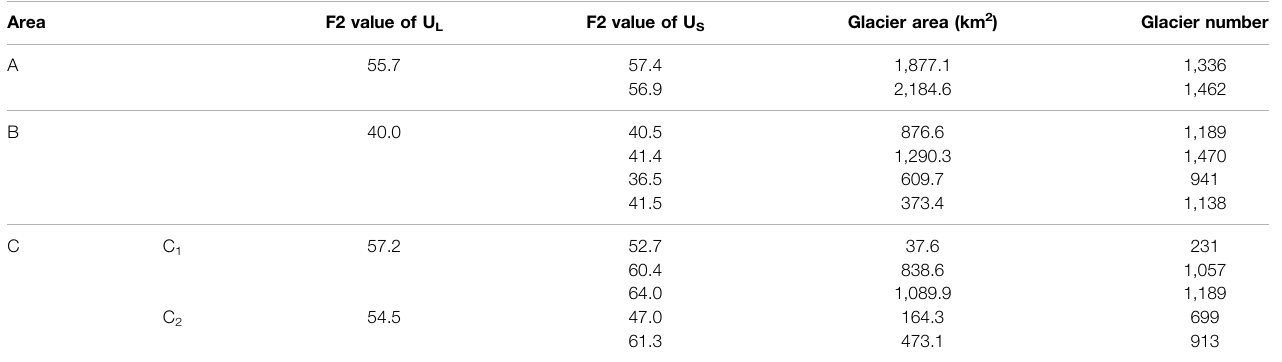
TABLE 7 | F2 values of the assessment units on two scales for each of the three areas A, B, and C in Figure 1 using the GGI18 inventory. The corresponding glacier areas and the number of glaciers in each assessment unit are also shown. Area F2 value of U L F2 value of U S Glacier area (km 2 ) Glacier